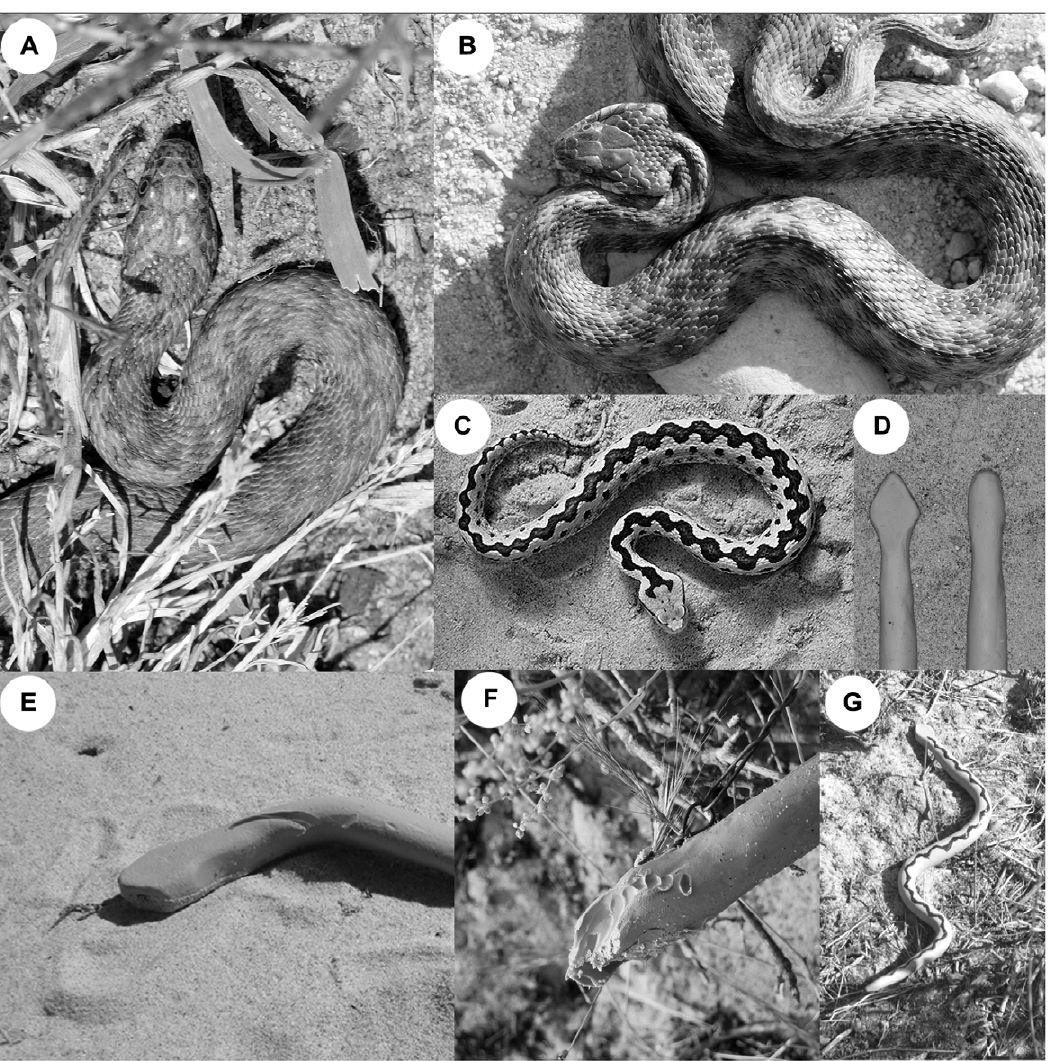
Figure 1. Head shapes of viper and viperine snakes. Natrix maura has a narrow colubrid-like head shape (a). When disturbed, they flatten their heads making the head more triangular in shape (b). Vipera latastei gaditana exhibit the typical triangular head shape of European vipers (c). Triangular, viper-like and narrow, colubrid-like head shapes of plasticine models (d). Attacks of raptors (e) and mammals (f) can be separated from imprints left during predation events. A dorsal zigzag pattern was painted on half of the snake replicas (g).